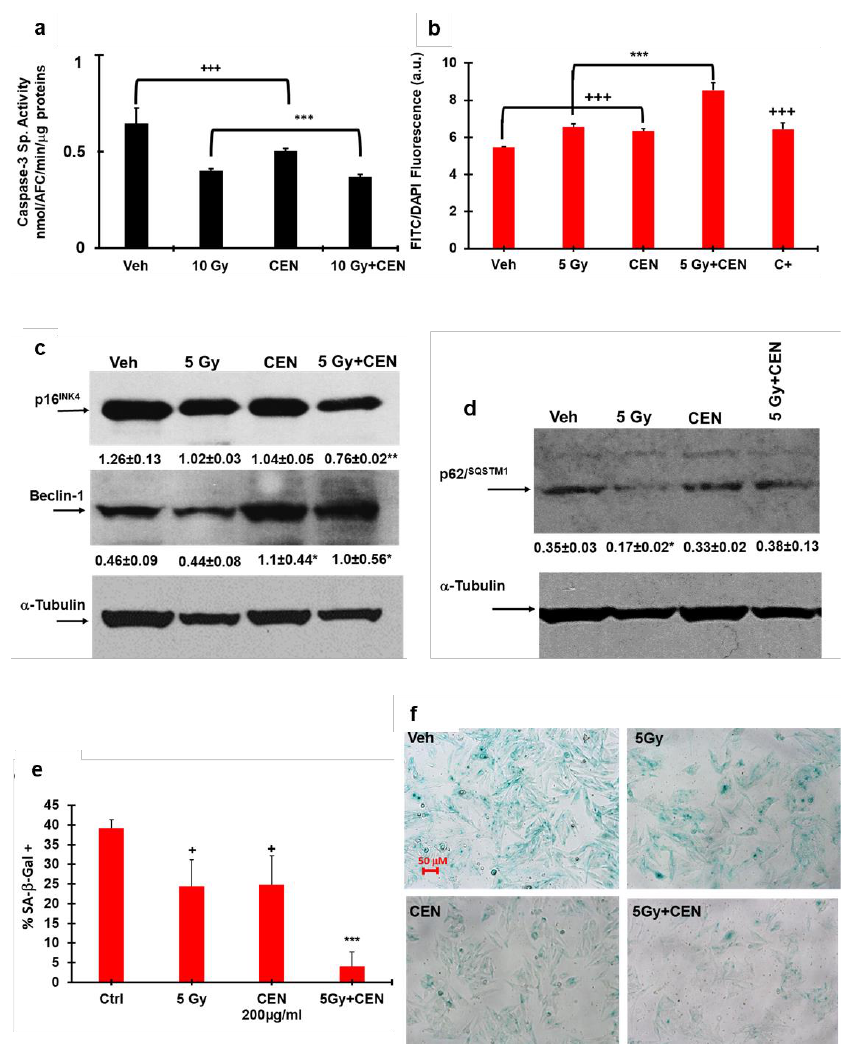
Figure 5. Irradiation and CEN do not induce apoptosis and modulate autophagy and senescence markers differently in SAOS400 cells. Panel ( a ): Caspase-3 enzymatic activity. The cells were irradiated (10 Gy) and then incubated with 200 µ g/mL of CEN or their combinations, and after 24 h the cells were harvested, washed in PBS, and resuspended in caspase cell lysis buffer. Caspase-3 activity was measured fluorometrically using the specific substrate DEVD-AFC, as previously described [25]. Bar graphs represent the mean ± SD, and symbols and the linear bar indicate significance: +++ p < 0.01 CEN vs. Veh, *** p < 0.01 10 Gy and CEN vs. CEN + 10 Gy, Student’s t test. ( b ) Cyto-ID staining of SAOS400 cells irradiated with 5 Gy and treated for 120 h with 200 µ g/mL of CEN or their combinations. CLO (20 µ M) was used as a positive control in this experiment (C+). The bar graphs represent the mean ± SD, and symbols and the linear bar indicate significance: +++ p < 0.001 IR and CEN vs. Veh, *** p < 0.001 CEN + IR vs. single treatments (Student’s t test). Panels ( c , d ): Immunoblot analysis of autophagy markers (Beclin-1, p62 SQSTM1 ) and senescence markers (p16 INK4 ) in SAOS400 cells irradiated with 5 Gy or incubated with 200 µ g/mL of CEN and their combination for 144 h. Densitometric analysis (numbers between panels indicate mean ± SD) was calculated normalizing the expression of Beclin-1, p16 INK4 , and p62 SQSTM1 with that of α -tubulin, as described in the Materials and Methods Section. Symbols indicate significance, * p < 0.05, ** p < 0.01 CEN + IR vs. IR or Veh (Student’s t test). Panel ( e ): SA- β -GAL staining of SAOS400 cells irradiated (5 Gy) and then treated for 144 h with 200 µ g/mL of CEN or their combination Symbols indicate significance + p < 0.05 IR or CEN vs Ctrl *** p < 0.01 CEN + IR vs. IR and CEN. Panel ( f ): Micrographs of representative fields of SAOS400 cells after SA- β -GAL staining (200 ×